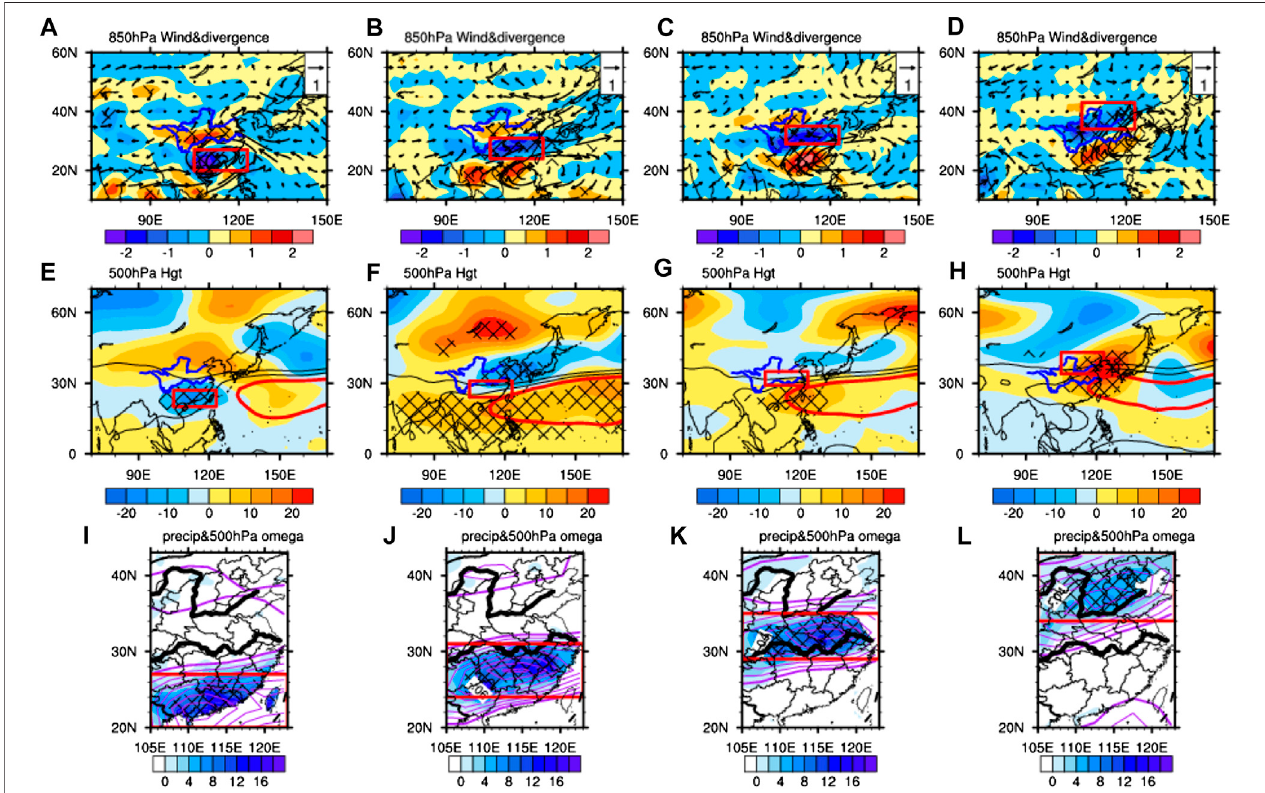
FIGURE 7 | The composite anomalies of wind (vectors, unit: m s − 1 ) and divergence (shading, unit: 10 6 s − 1 ) at 850 hPa (A – D) , geopotential height (shading, unit: gpm) at 500 hPa (E – H) , vertical velocity at 500 hPa (contours, unit: Pa s − 1 ), and precipitation (shading, unit: mm per pentad) (I – L) in SC (A,E,I) , SYR (B,F,J) , JHR (C,G,K) , and NC (D,H,L) . In (E – H) , the thick red curly line is 588 gpm isoline that is used to indicate the western Paci fi c subtropical high. The red box in (A – L) indicates the speci fi c cluster region. The hatched area indicates the 95% con fi dence